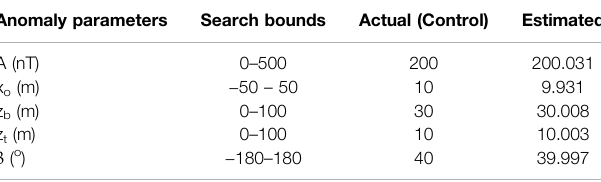
TABLE 2 | Bounds, actual and estimated parameters for uncorrupted synthetic magnetic anomaly.